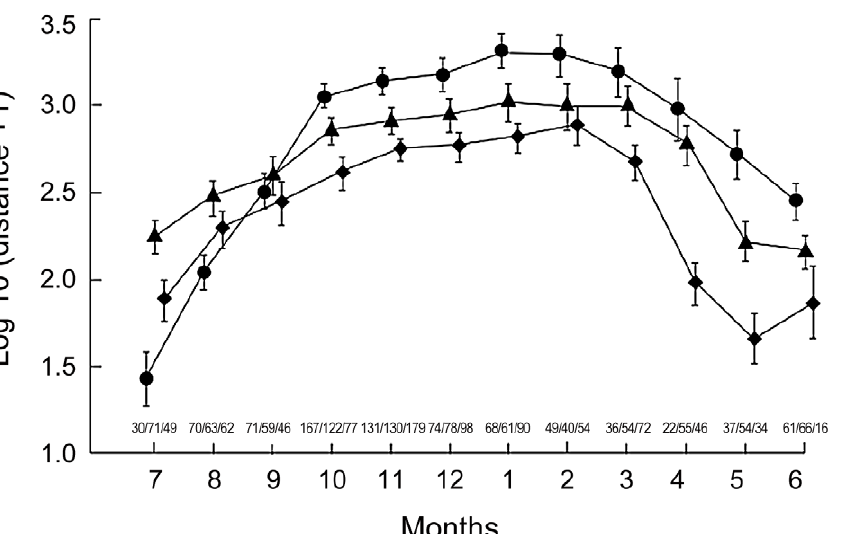
Figure 1. Annual distribution range of Larusfuscus by age classes. Mean values for distribution ranges are given by symbols. Diamonds, Class 0- and 1-year-old gulls (sexually immature); Triangles, 2-year-old gulls (first breeding year); Circles, 3 or more-years-old gulls (sexually mature). Bars, 95% confidence interval. At the bottom, sample sizes are given for each mean value in each month in the following order; class 0-1/class 2/class 3 or older.